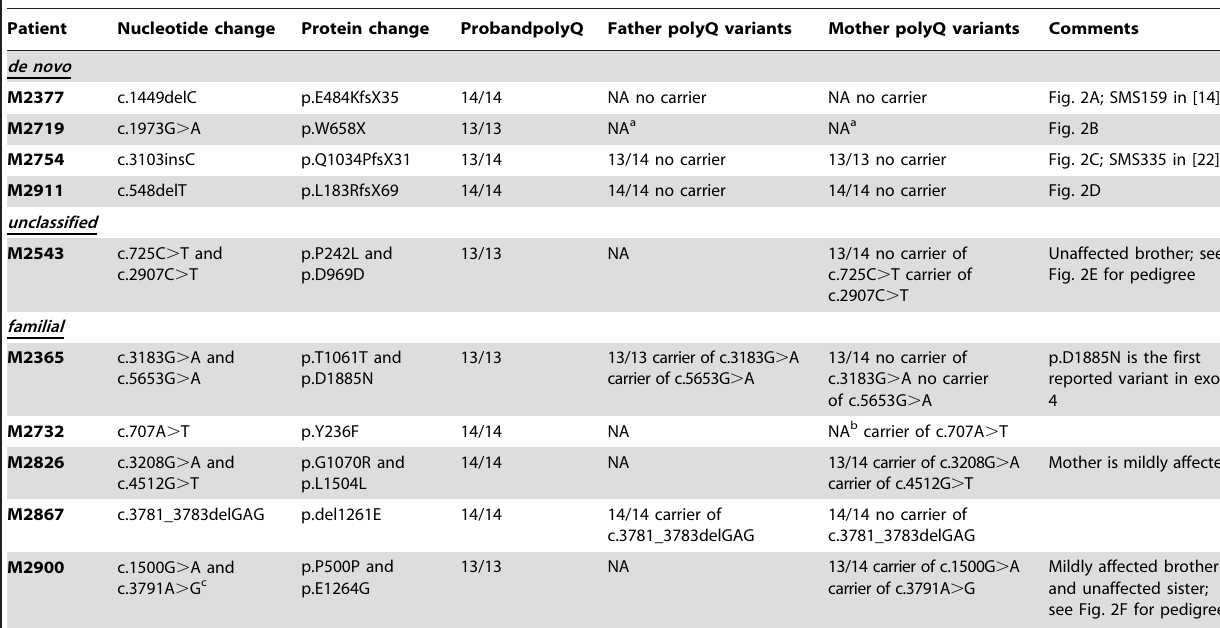
Table 1. RAI1 variants in SMS patients without 17p11.2 deletion identified in the current study.